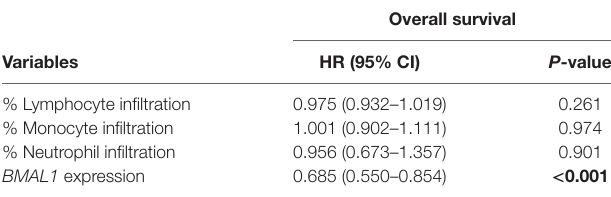
TaBle 3 | Multivariate Cox regression analysis of overall survival in metastatic melanomas adjusted for the percentage of immune cell infiltration in The Cancer Genome Atlas metastatic